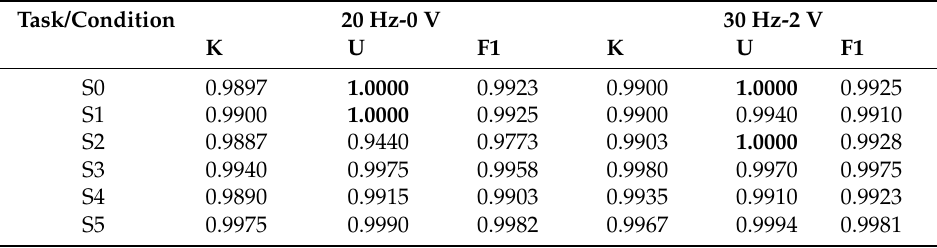
Table 8. Experimental results of the SEU dataset.